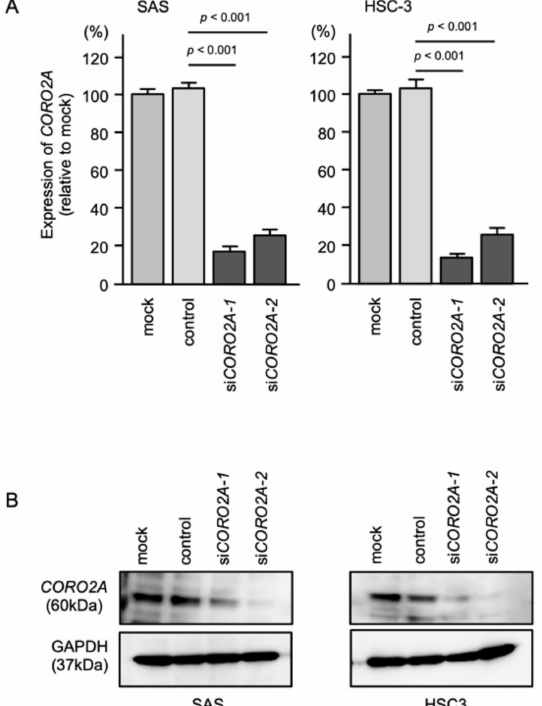
Figure 5. Knockdown efficiencies of siRNAs in OSCC cell lines (SAS and HSC-3 cells). Knockdown efficiencies of CORO2A expression by siCORO2A-1 and siCORO2A-2 were evaluated by real-time PCR ( A ) and Western blotting ( B ). Data of expression of CORO2A (mRNA) and CORO2A (protein) were collected 72 h after siRNAs transfection. GAPDH (mRNA) and GAPDH (protein) were used as internal